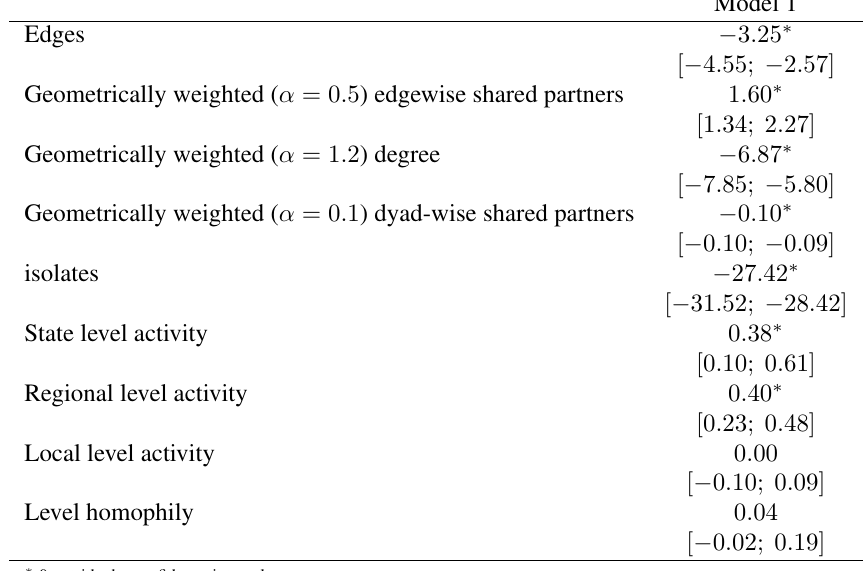
Table A1.1 : Coefficients of pooled exponential random graph model used to generate baseline distributions in permuta-tional analysis. Confidence intervals in square